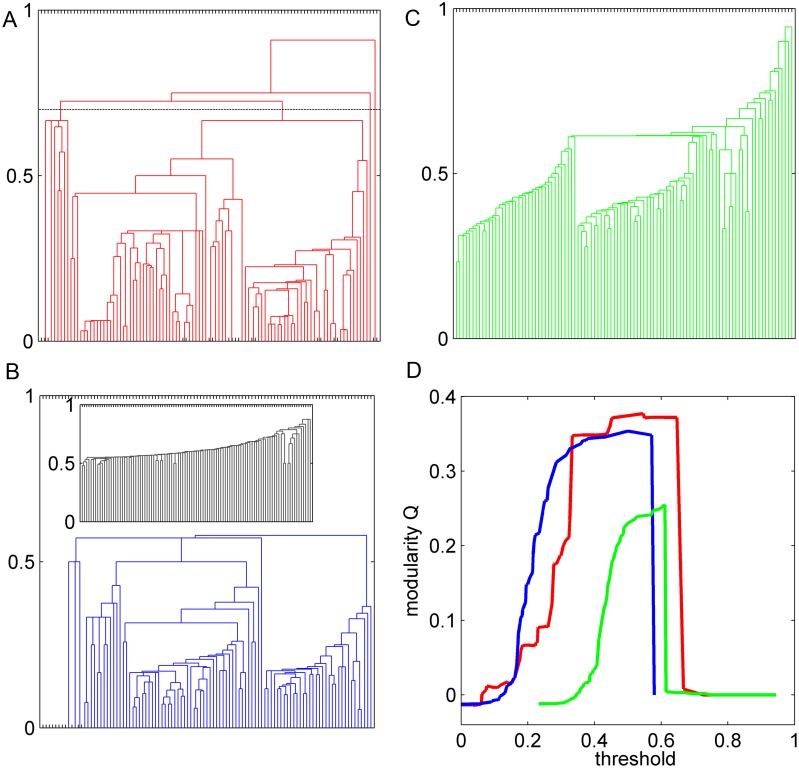
Comparison of hierarchical modular organization of the real and surrogate networks.Hierarchy trees for the real network (A), reconstructed network (B) and R-network (C) where the unrecovered links of LDCs in the original network are rewired while keeping the wiring cost. Inset of B: random network rewired from the real network while keeping the degrees. (D) Modularity Q as a function of the threshold values for the trees in A, B and C (corresponding colors).